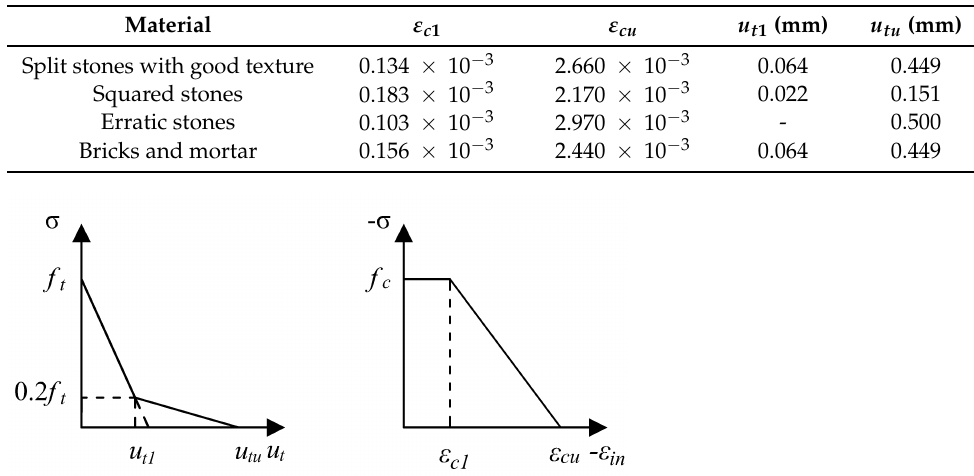
Figure 4. Shape of the uni-axial post-elastic responses for traction and compression defined for the masonry materials. For graphical reasons, the compressive stress–strain values are plotted as